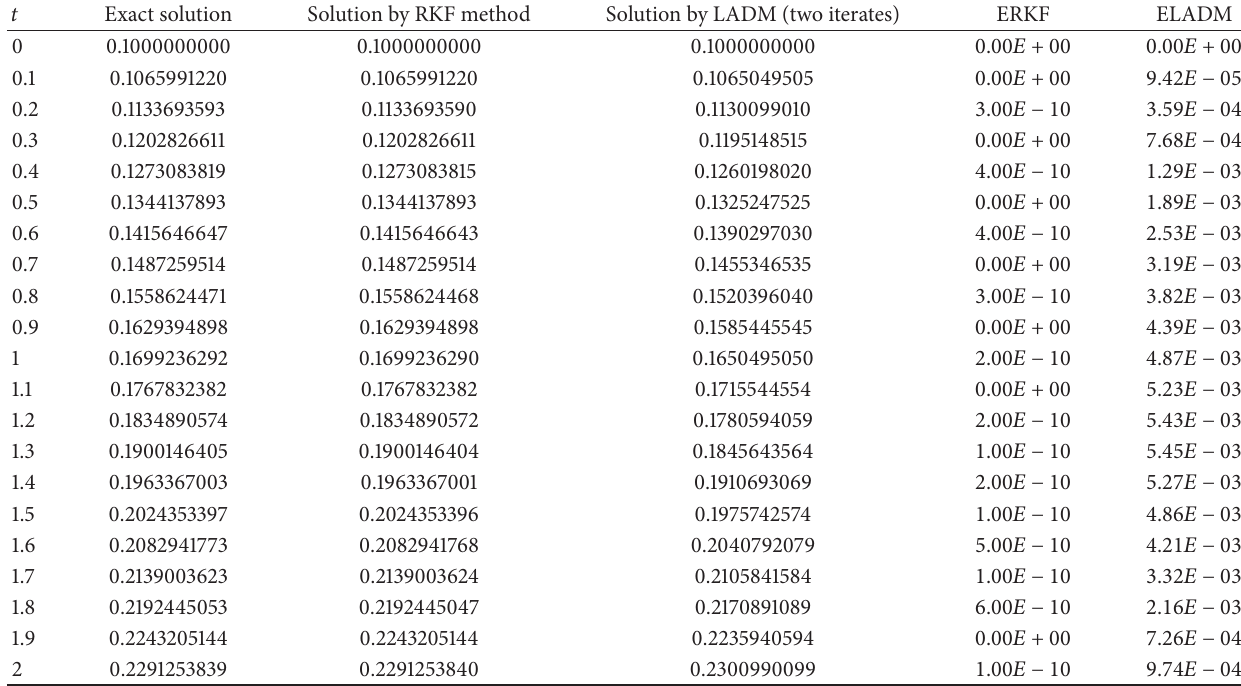
Table 5: Numerical comparison when 𝑁(0) = 0.1 , 𝑎 = 3 , 𝑏 = 1 , 𝛼 = 0.5 , 𝛽 = 1 , ℎ = 0.1